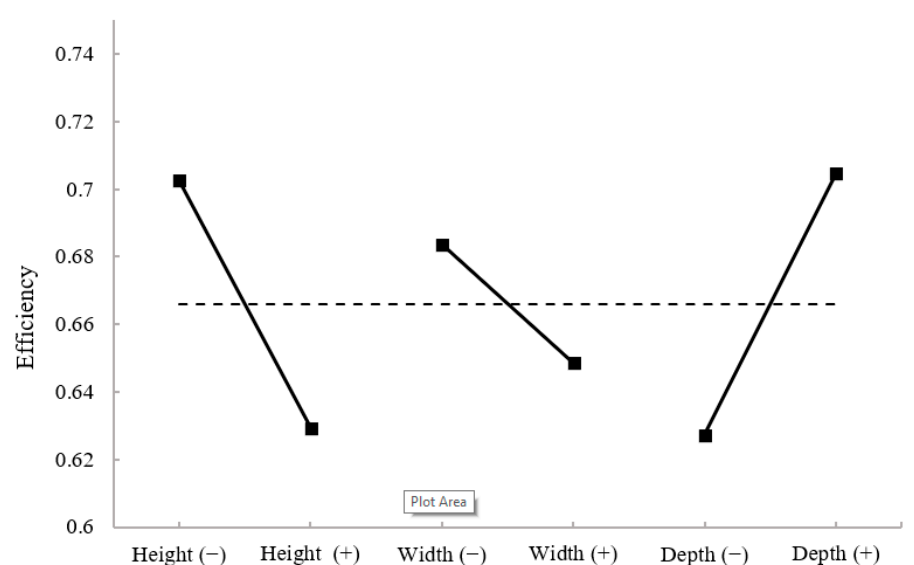
Figure 13. Main effects of height, width, and depth in the DOE study. The ( − ) and (+) refer to changes to the original dimensions of − 7% and +7%, respectively.